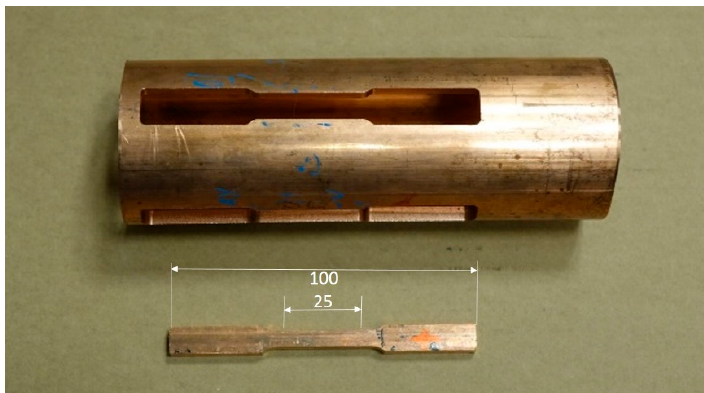
Figure 5. Tensile sample cut from the Cu tube wall. All dimensions in mm.